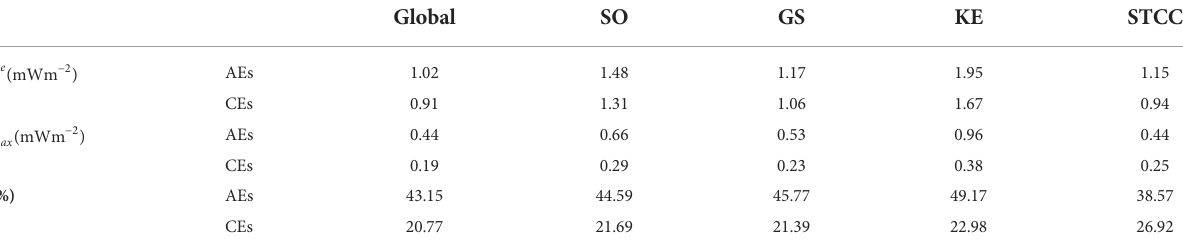
TABLE 1 Composites of W Ie , maximum downward NIW energy fl ux (cid:1) F e max under the SBL base, and their ratio r ¼ (cid:1) F e max =W Ie for AEs and CEs in the global ocean and different